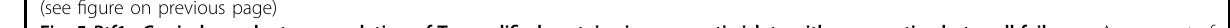
protein response 3 . Interestingly, GRP78 associates with T- synthase in cancer cell lines de fi cient in Cosmc 33 . Gen-